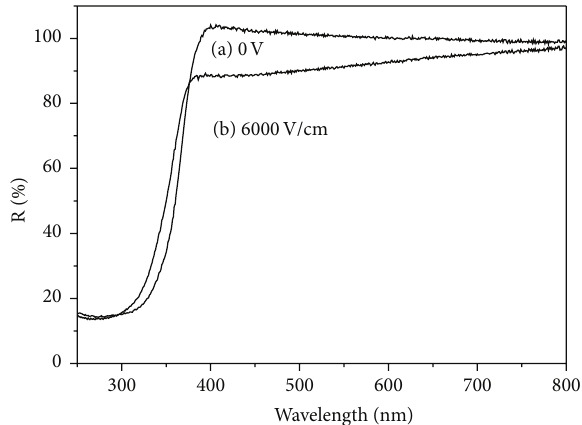
Figure 5: UV-Vis DRS of the composite film annealed at 500 ∘ C for 1h: (a) 0V and (b) 6000